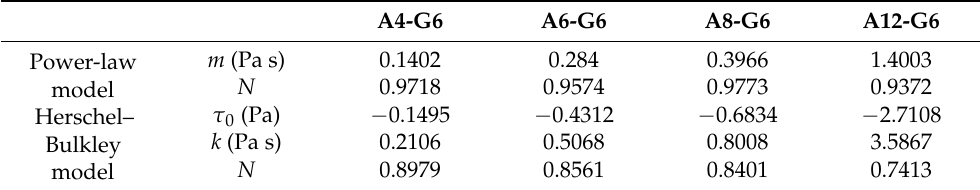
Figure 3. Rheological analysis of the inks. ( a ) Amplitude sweep test (Elastic modulus (G ′ ), storage modulus (G ′′ ) vs. strain (%)). ( b ) Frequency sweep test (Elastic modulus (G ′ ), storage modulus (G ′′ ) vs. angular frequency ( ω (rad/s)). ( c ) Viscosity (Pa.s) was plotted as a function of shear rate ( 𝛾 ̇ (1/s). ( d ) Evaluation of flow behavior with shear stress (s) vs. shear rate ( 𝛾 ̇ ) curves. Table 6. Parameters m and n from a power-law model fit to the flow curves of various gels, prepared with increasing gelatin loading. The overall model fits the experimental data were significant in each case ( p < 0.05), with all the model parameters also being significant ( p <